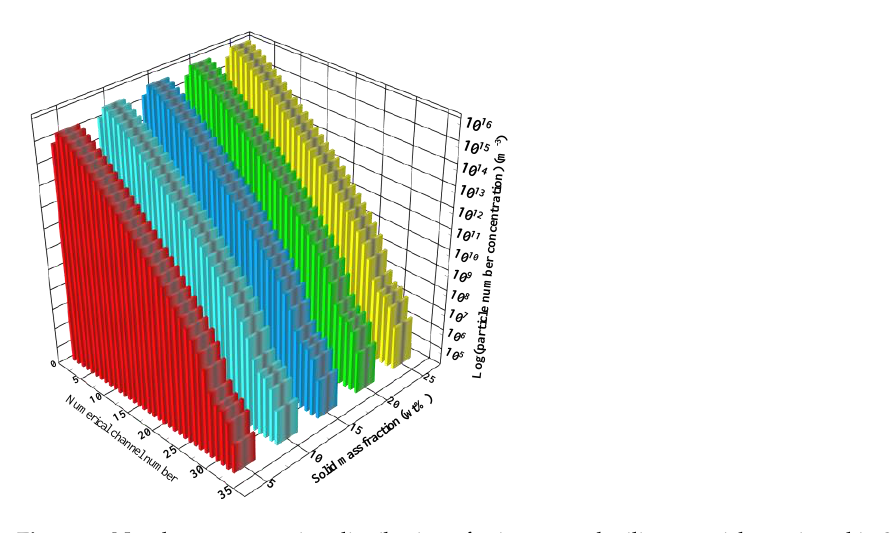
Figure 3. Number concentration distribution of primary total tailings particles assigned in 37 chan- nels.